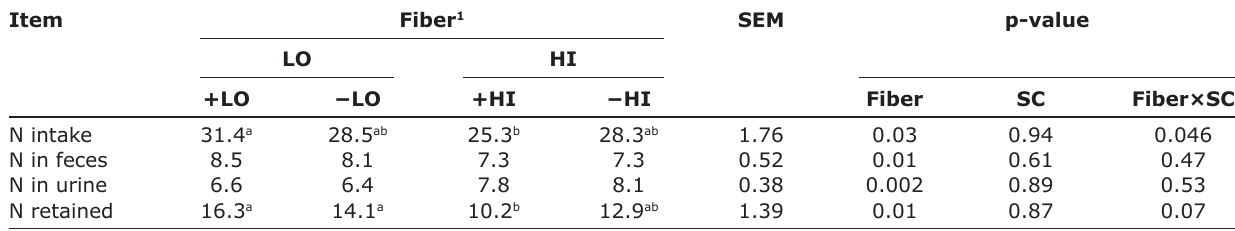
Table-4: Effect of SC supplementation in Awassi female lambs fed with LO- and HI-fiber diets on nitrogen balance (g/d). Item